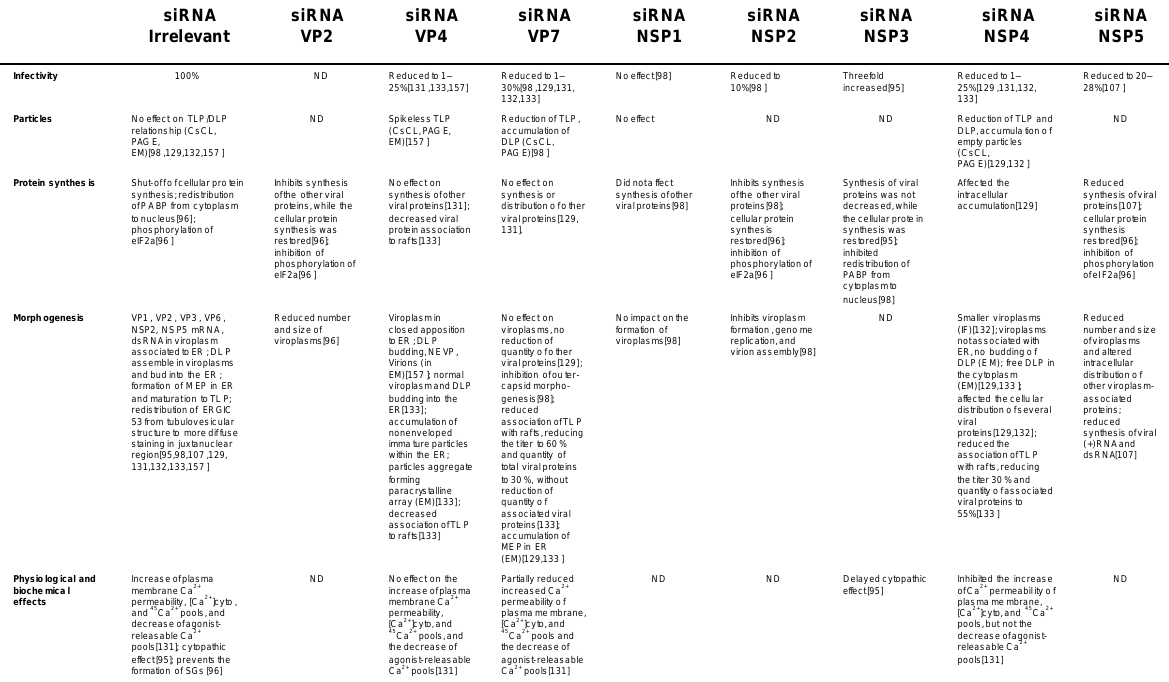
Physiological and biochemical effects